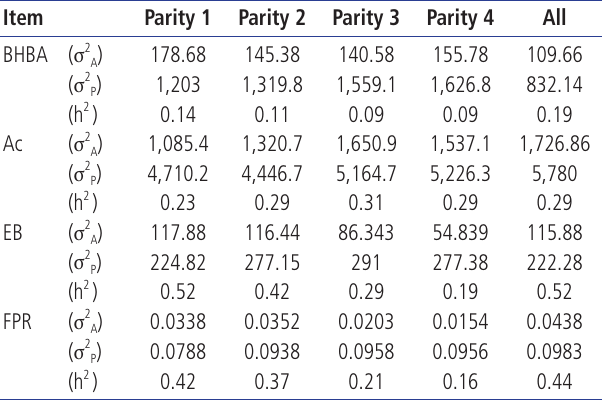
Table 3. Additive genetic variance ( σ 2 heritability (h 2 ) estimates of different parities Item